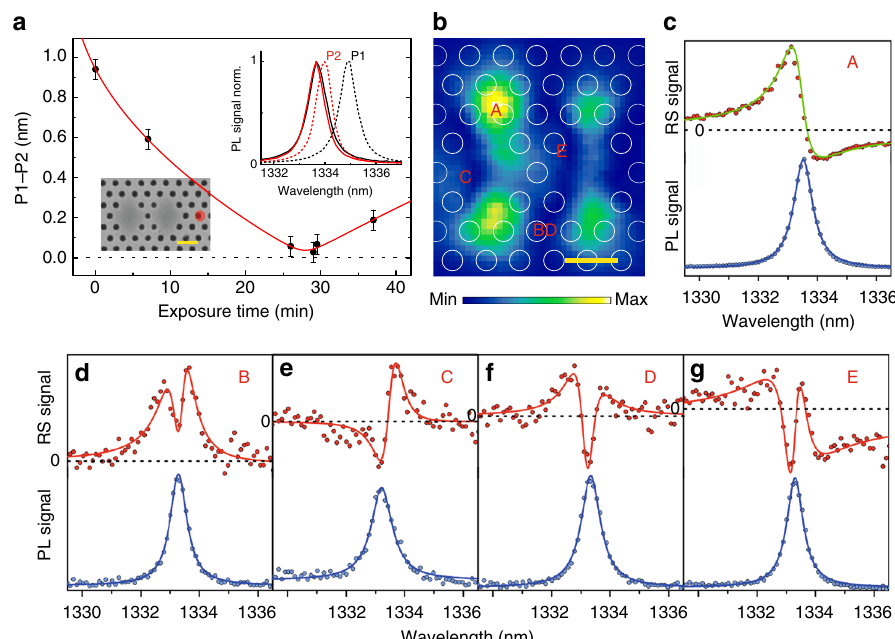
Fig. 4 Generalized Fano lineshapes in a photonic molecule. a Spectral difference between the modes with larger (P1) and shorter (P2) wavelength as a function of the oxidation-laser exposure time. The red line represents the fi t obtained by the coupled-mode theory, see Supplementary Note 8. The error bars are given by the sum of the uncertainties provided by the Lorentzian fi t of each mode. Bottom inset: scanning electronic microscope image of the photonic molecule where the red spot marks the position of the oxidation-laser and the scale bar corresponds to 500 nm. Top inset: photoluminescence (PL) spectra collected on the right cavity (where P1 is initially localized) and on the left cavity (where P2 is initially localized) shown as red and black lines, respectively, at t = 0 (dashed lines) and at t = 29 min (solid lines). b Resonant-scattering (RS) amplitude map at t = 29 min. A, B, C, D, and E indicate the positions where the spectra of c – g are collected. c – g RS and PL data reported as red and blue points, respectively. The blue lines are Lorentzian fi ts. The green line in c is a standard Fano pro fi le fi t by Supplementary Eq. (15). The red lines in d – g are generalized Fano pro fi le fi ts by Supplementary Eq. (21). Horizontal dashed lines represent the zero value of each RS pro fi